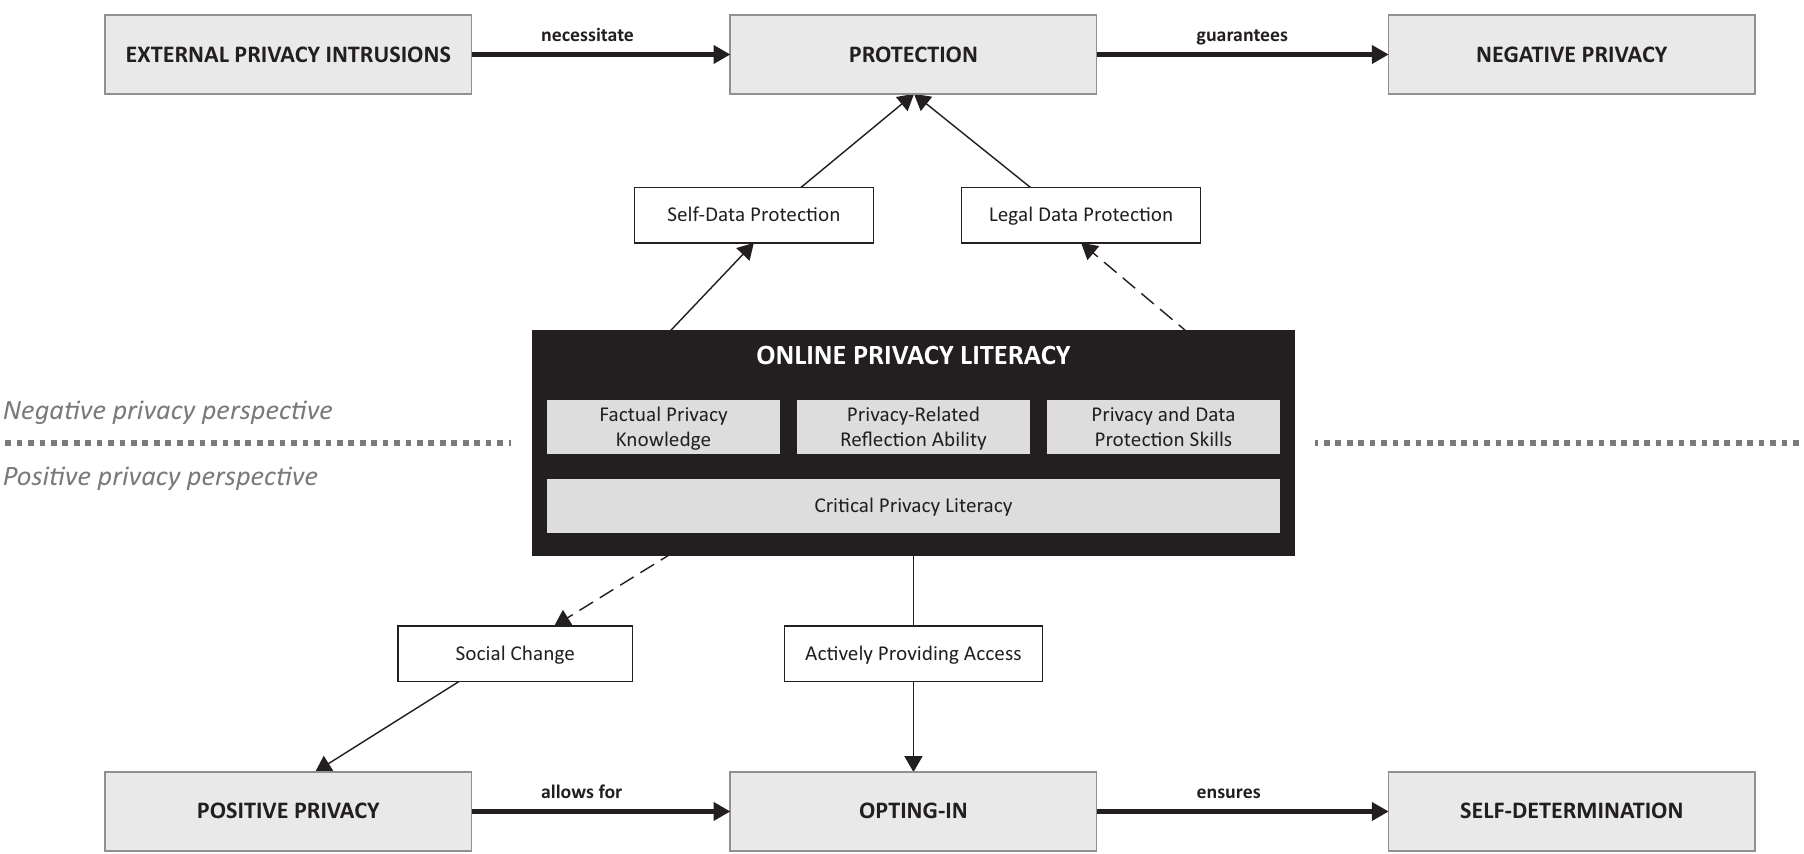
Figure 2. How online privacy literacy supports privacy protection (negative perspective) and informational self-determination (positive perspective). Notes: The dotted arrows represent indirect influences via democratic processes (e.g., changing data protection laws and regulations is only possible via policy making. Individuals can thus only vote for politicians that represent their wishes in the policy making process). Continuous arrows represent direct influences (e.g., with appropriate factual knowledge and data protection skills, individuals can protect themselves and thus ensure protection against external privacy intrusion to guarantee negative